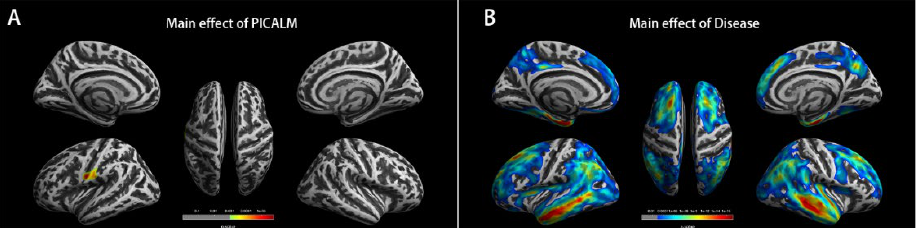
Figure 1. The main effects analysis. Note: ( A ) The brain map represents the main effect of PICALM factor on cortex thickness. The cortex thickness of left postcentral cortex is significantly different between rs3851179 A-carriers and GG-carriers after FWE correction (cluster level). ( B ) The brain map represents the main effect of Disease factor on cortex thickness. The cortex thicknesses of bilateral temporal and prefrontal cortex are the most significantly different among CN, MCI, and LOAD group. Table 1. The main effects of PICALM on cortex thickness.